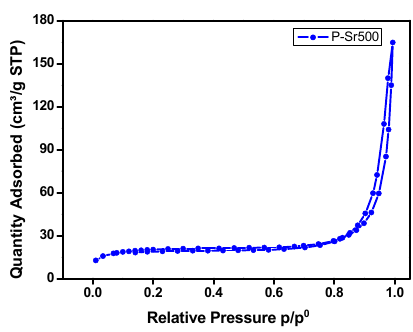
Figure 6. Nitrogen adsorption-desorption isotherms (BET) of P-Sr500 nanocomposite.